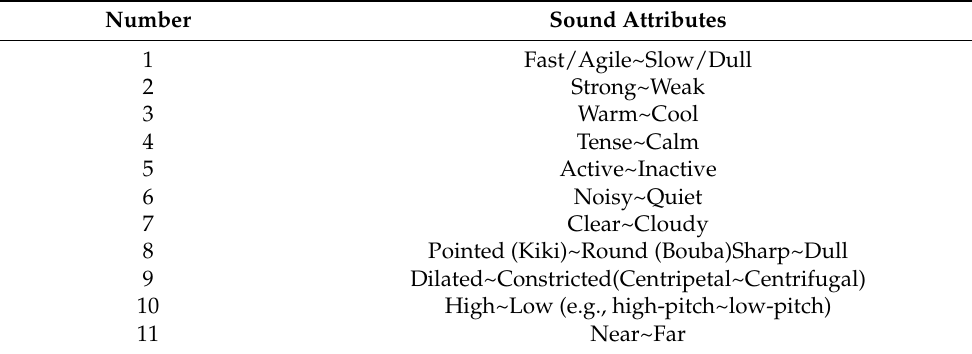
Table 6. The adjective pairs used in the